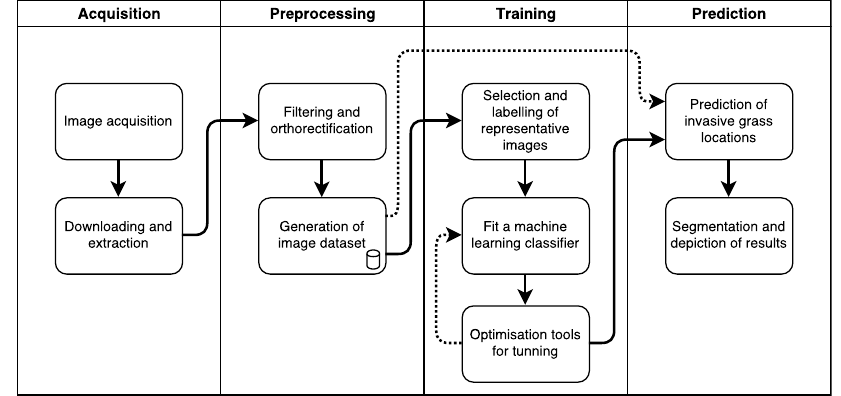
Figure 1. Primary pipeline for mapping of invasive grasses and related vegetation.